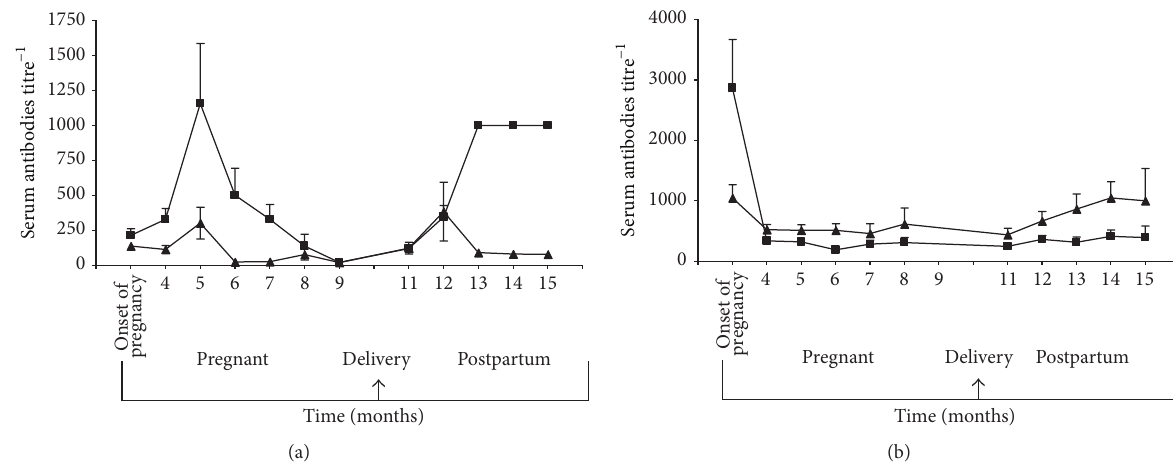
Figure 2: Mean ( ± SE) serum thyroid peroxidase (TPO) ( ◼ ) and thyroglobulin (Tg) ( 󳵳 ) antibody titres, measured in standard enzyme- linked immunosorbent assay, in pregnant women with Graves hyperthyroidism (a) and Hashimoto thyroiditis (b) tested before, during, and following pregnancy. Results are expressed as titre −1 .